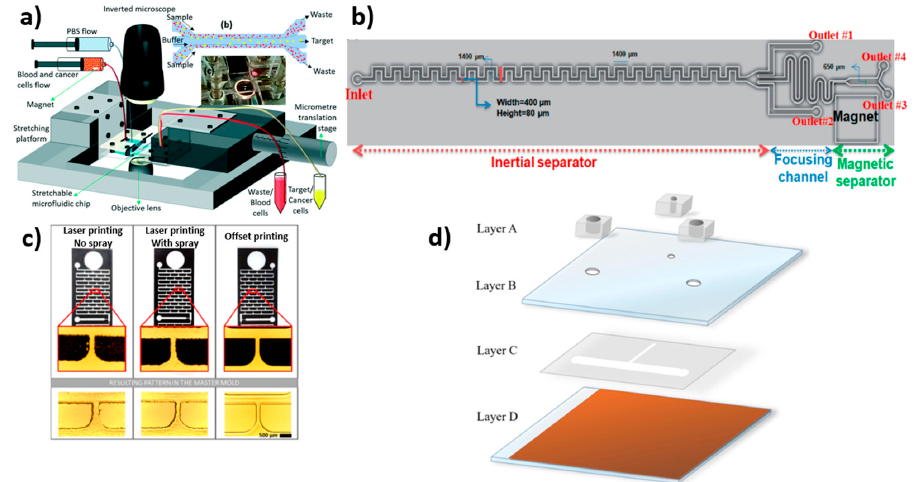
Figure 3. Microfluidic device designs fabricated using various techniques. ( a ) Schematic of the working setup of the stretchable microfluidic device, with an inset showing the multi-flow microchannel with a real stretchable microfluidic device; reprinted with permission from ref. [102], 2021, Royal Society of Chemistry. ( b ) Schematic of hybrid microfluidic cell separation device showing CTC sorting by an inertial focusing microchannel followed by magnetic separation [107]. ( c ) Photomasks fabricated using offset printing showed better resolution and smooth surface over other laser printing techniques [108]. ( d ) Schematic illustration of the optically induced dielectrophoresis (ODEP) microfluidic system assembly where Layer A was composed of fabricated polydimethylsiloxane (PDMS) components; Layer B was composed of indium-tin-oxide (ITO) glass; Layer C was composed of double-sided adhesive tape with microfabricated microchannels; and Layer D was composed of ITO glass substrate coated with a layer of photoconductive material [85].